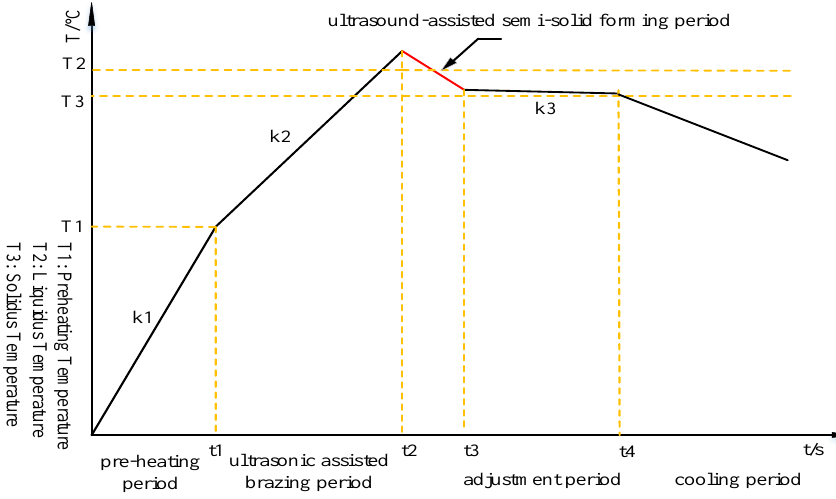
Figure 2. Sequence diagram of ultrasonic assisted one-side core semisolid brazing process.